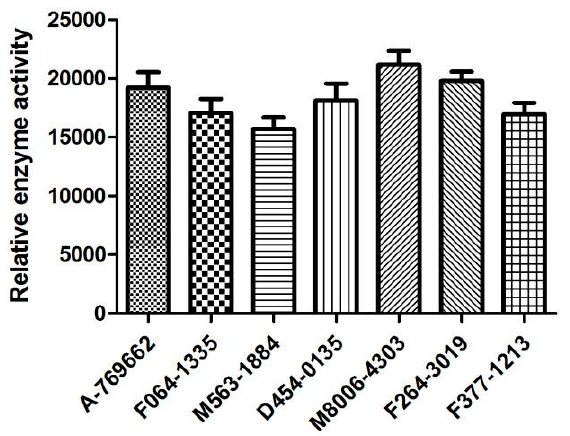
Figure 9. Activation of AMPK ( α 1 β 1 γ 1 isoform) by the screened compounds was measured using Elisa Kit.